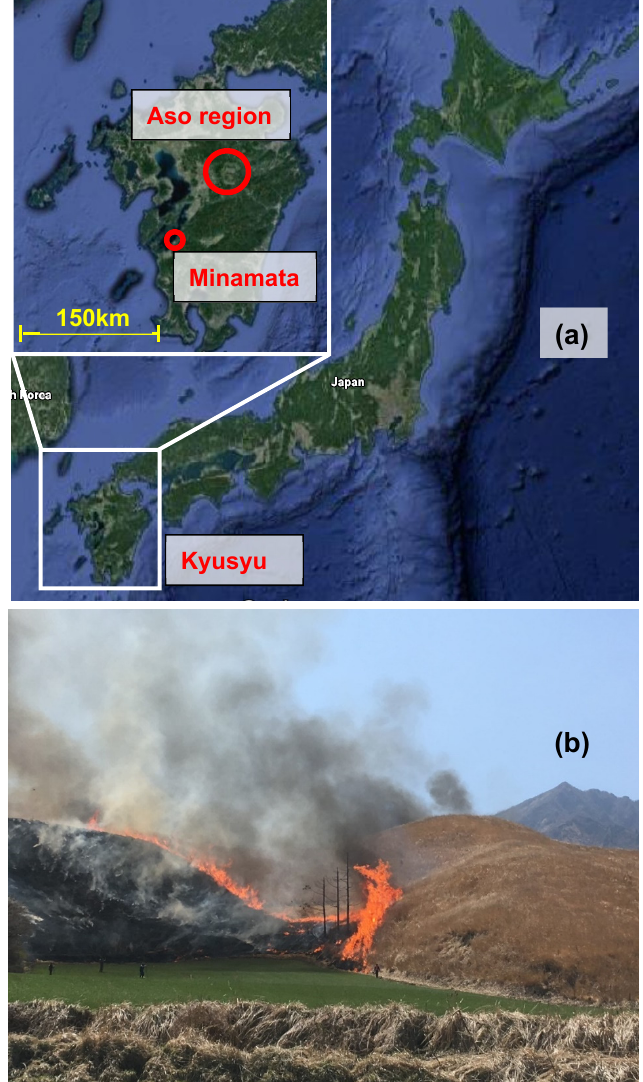
Figure 3. ( a ) A map of the Aso region in Kyusyu, Japan (Google Maps) and ( b ) a photo of the Aso open field burning (Noyaki) in 2019. This annual event in spring burns 161 km 2 of the natural grass field and stock farms to sustain healthy grass fields in this region.